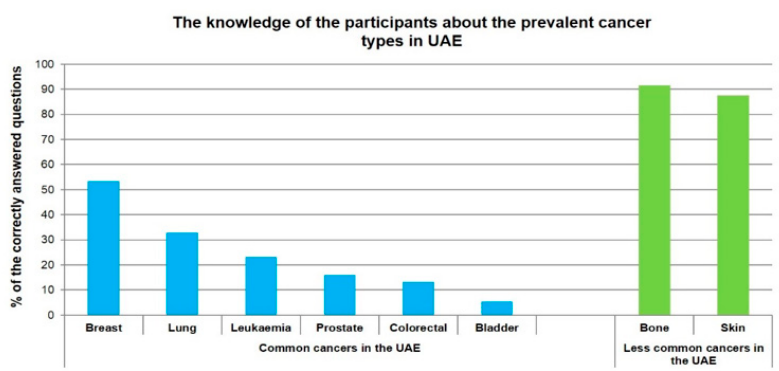
Figure 2. The knowledge of the participants regarding the prevalent cancer types in the UAE.